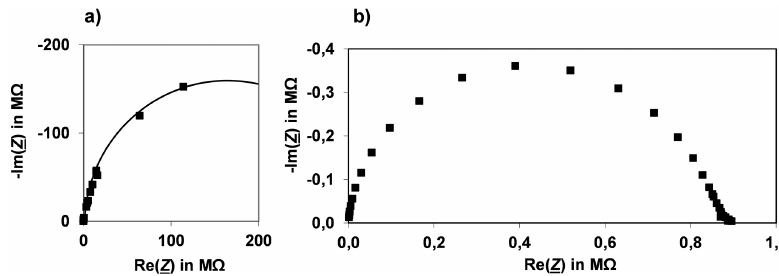
Figure 3. Typical Nyquist representation of the impedance of the single-particle sensor between 1Hz and 1MHz. T = 400 ◦ C. (a) Catalyst particle in the reduced state (10% H 2 in N 2 ). (b) Catalyst particle is sulfidized for 1min in 500ppm H 2 S in N 2 .